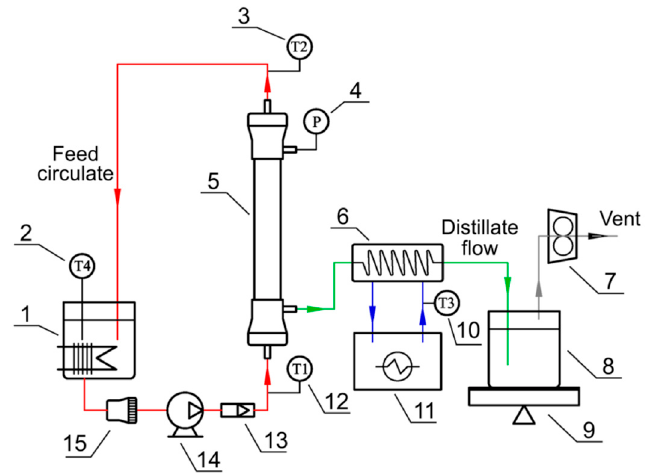
Figure 1. Schematic of the vacuum membrane distillation (VMD) system for stabilized urine treatment: 1, feed tank with heater; 2, 3, 10, 12, thermometers (T1 and T2: membrane module inlet and outlet; T3: cooling water; T4: feedstock); 4, vacuum transducer; 5, membrane module; 6, coil condenser; 7, vacuum pump; 8, distillate tank (sealed); 9, online balance; 11, cryostat; 13, water flow meter; 14, magnetic pump; 15, melt-blown filter (25 µ